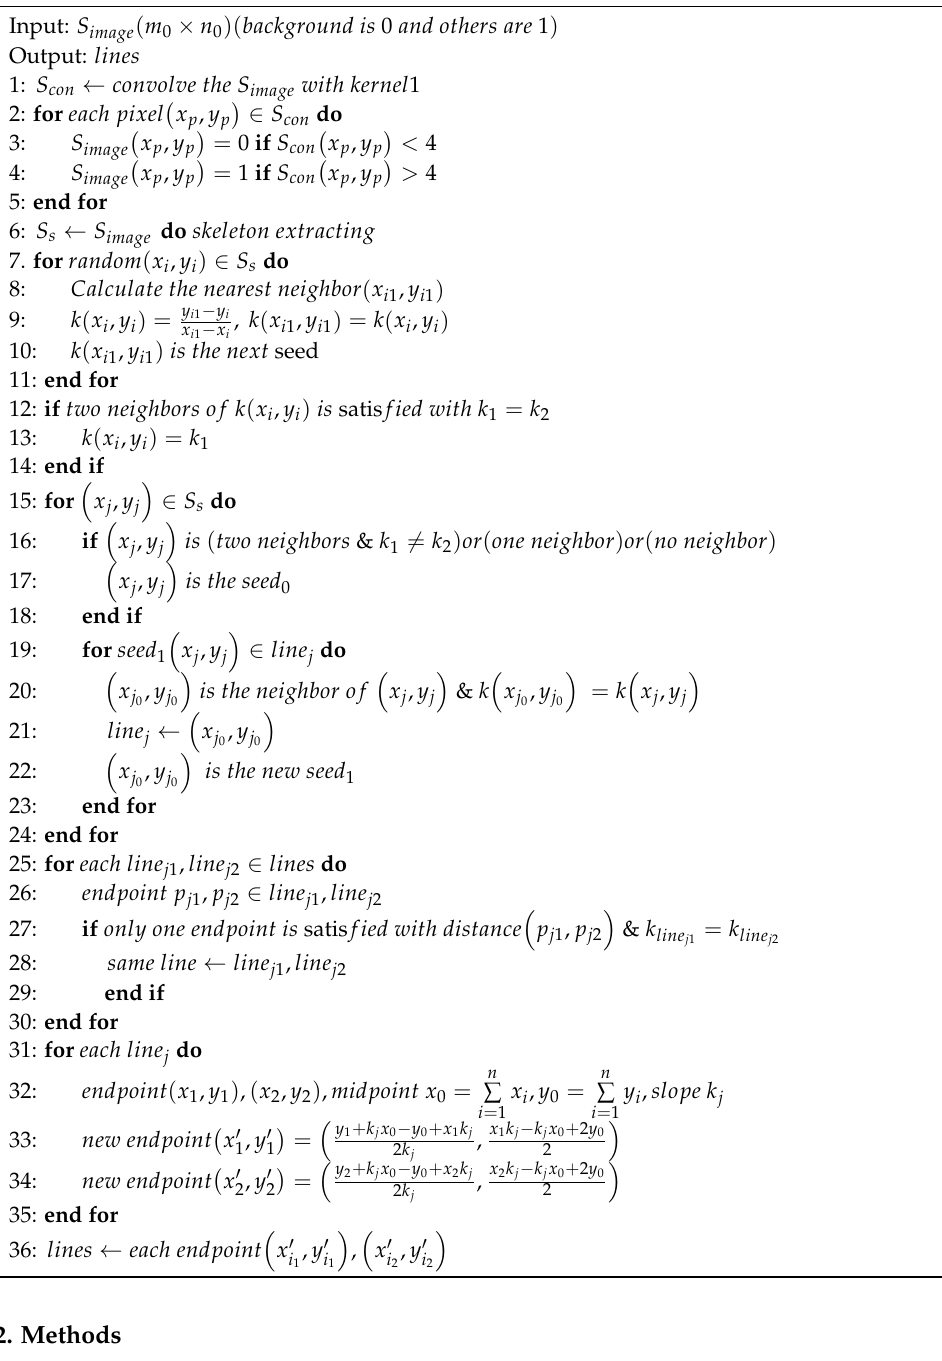
Algorithm 4 Line segment extraction